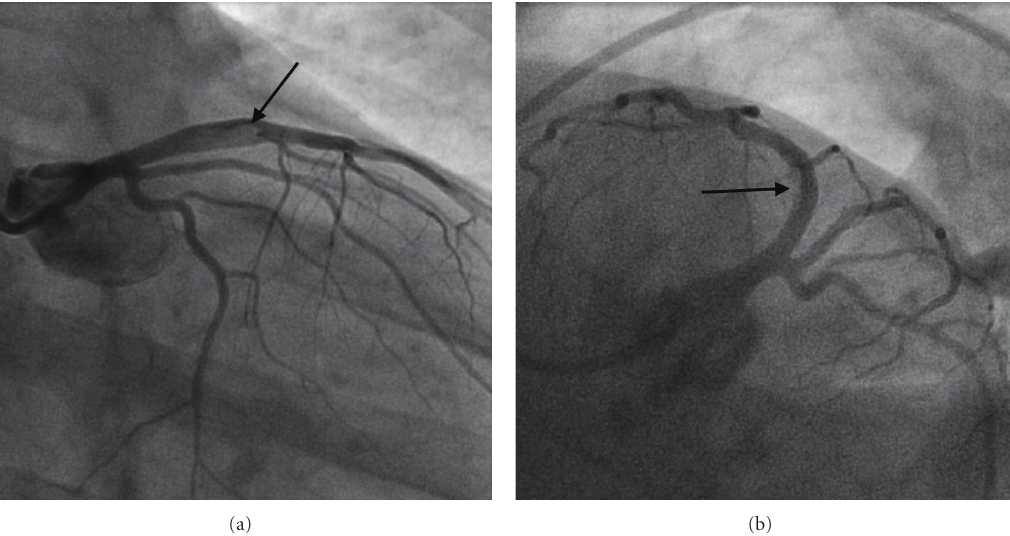
Figure 1: (a) 6 French diagnostic catheter in the right anterior oblique with caudal angulation. (b) In the left anterior oblique with caudal angulation (spider view). Arrow showing the presence of thrombus in the proximal left anterior descending artery.